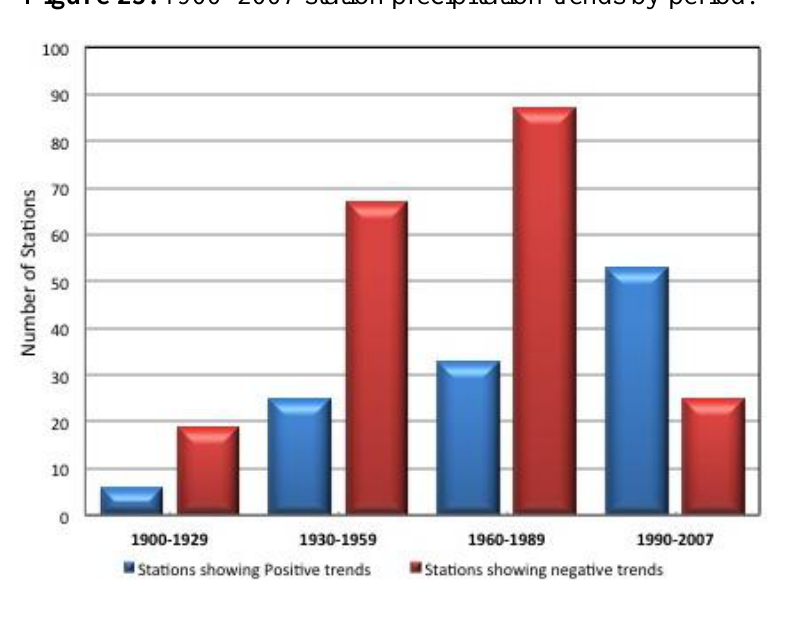
Figure 23. 1900–2007 station precipitation trends by